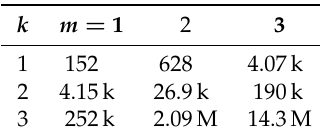
Table 1. Sizes of expressions generated during the iterative solution of Equation (30) for different iteration levels ( k ) and orders of expansion ( m ) with respect to δ . Values are given in characters, with SI prefixes used to represent larger